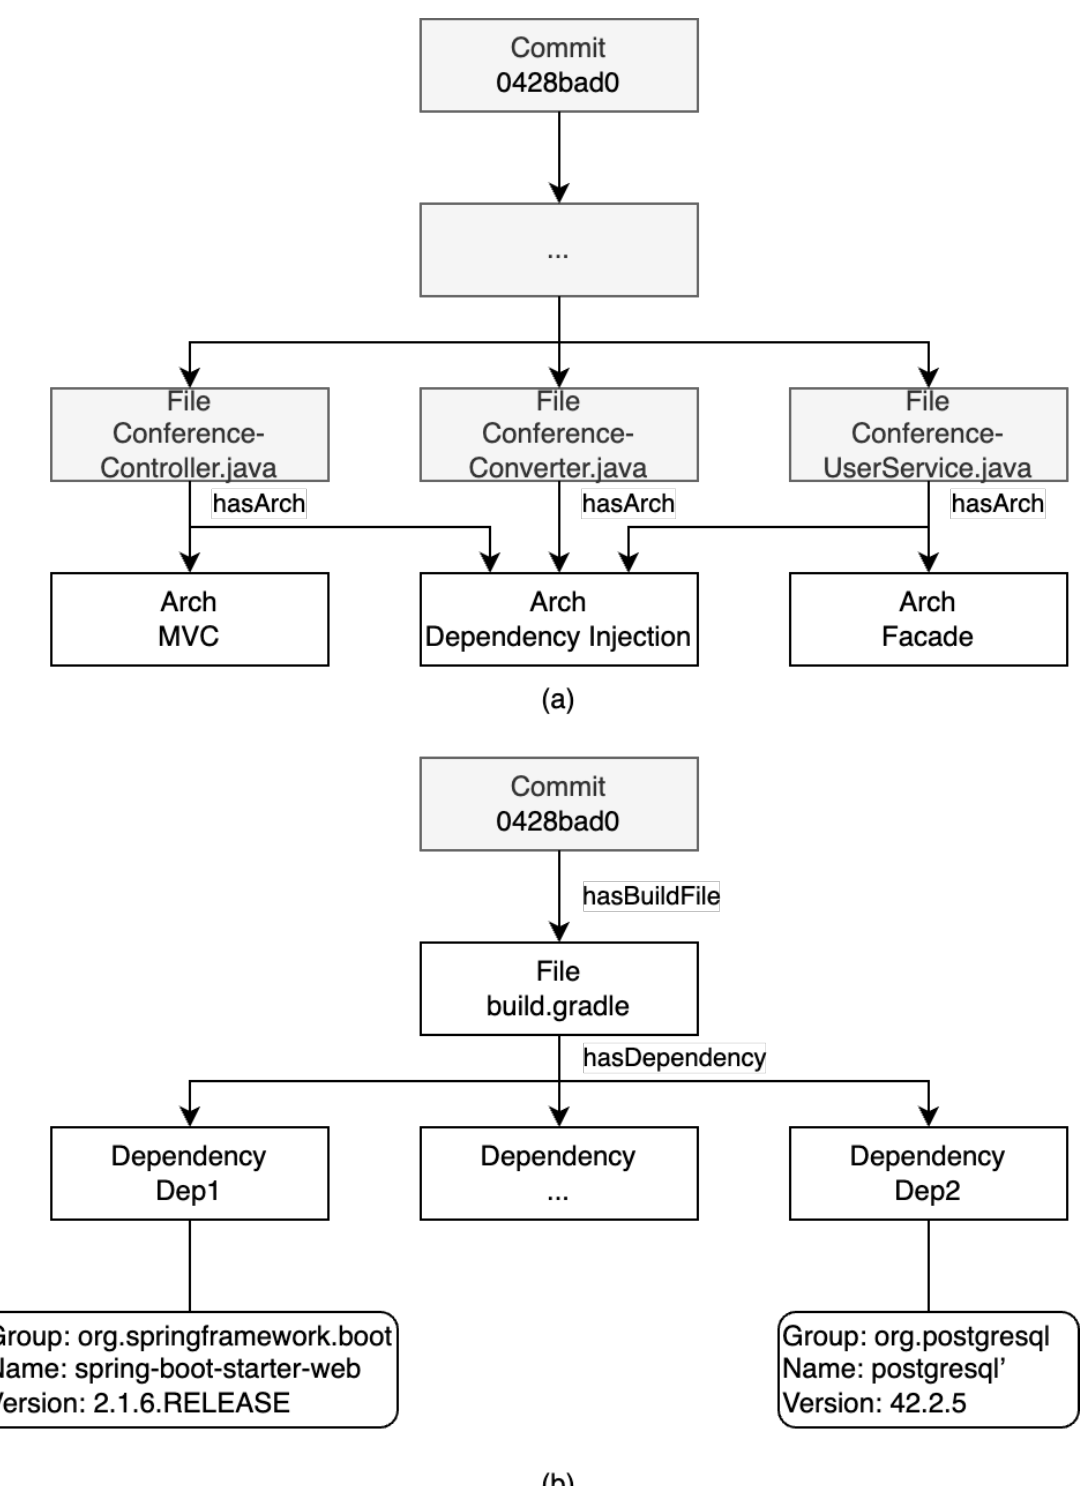
Figure 5. Example of the T B representation fragment: ( a ) a set of architectural styles; ( b ) a set of the third-party dependencies. Figure 6 demonstrates the example of the D B representation fragment. Step 5. Formation of the the linguistic environment W B